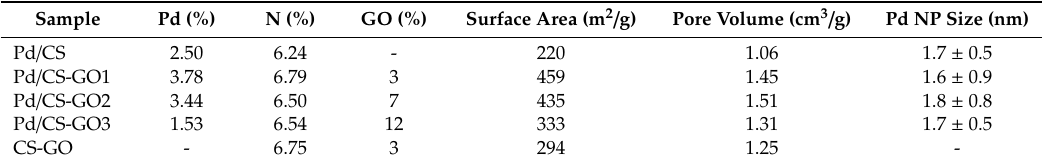
Scheme 1. Illustration of the preparation procedure of Pd/CS and Pd/CS-GO (Pd NPs embedded in chitosan-graphene oxide beads) samples. ( i ) CS or CS-GO precipitation in NaOH solution to form beads; ( ii ) Impregnation of CS or CS-GO beads in Pd(NH 3 ) 4 Cl 2 solution followed by NaBH 4 reduction; and ( iii ) supercritical CO 2 drying of the spheres. Table 1. Relevant analytical and textural data of the Chitosan (CS) supported Pd catalysts prepared in the present study.